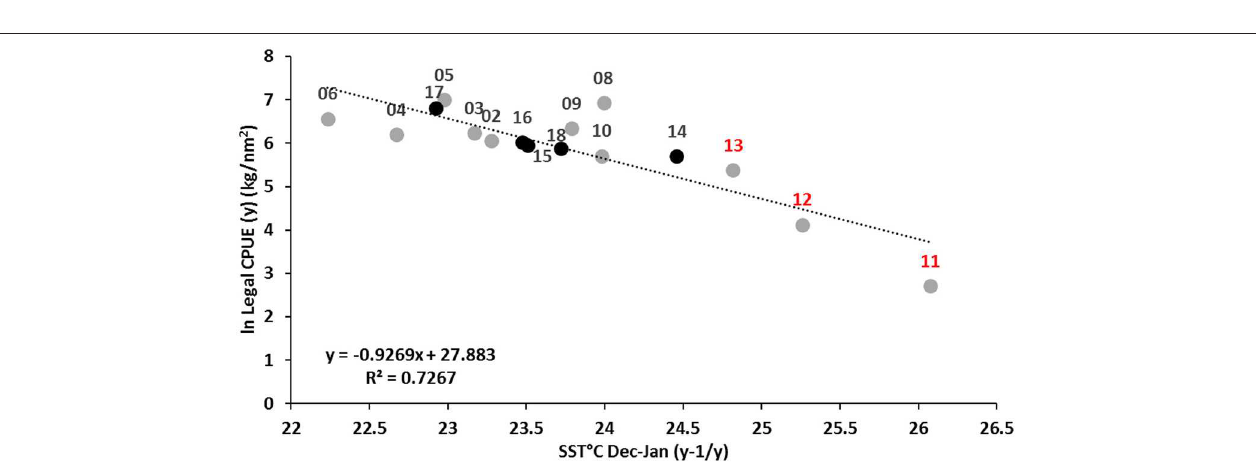
FIGURE 7 | Relationship between log-transformed legal crab catch rate during the survey in November (year y) and mean SST during December–January (y-1/ y). Stock decline and fishery closure years 2011–2013 shown in red; stock recovery years under quota management 2014–2018 indicated by solid black points. Survey data is not available for